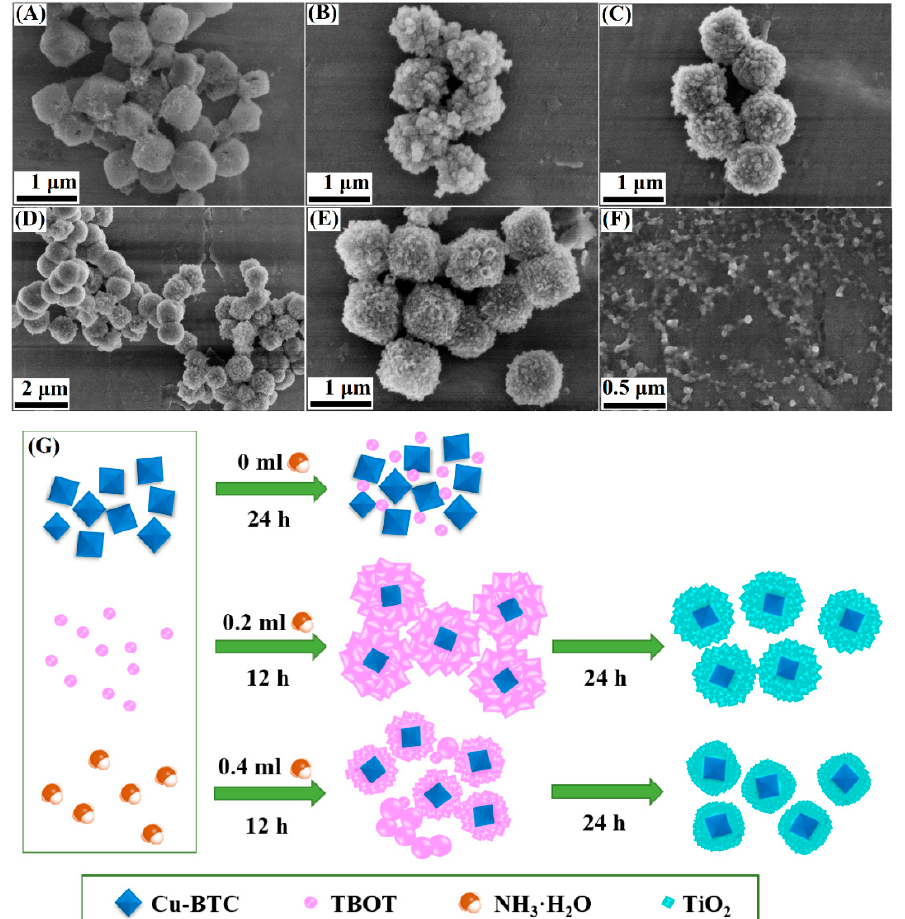
Figure 7. FESEM images of the synthesized Cu-BTC@TiO 2 with ammonia contents and reaction times of ( A ) 0 mL, ( B ) 2 mL for 12 h, ( C ) 2 mL for 24 h, ( D ) 4 mL for 12 h, ( E ) 4 mL for 24 h, as well as ( F )